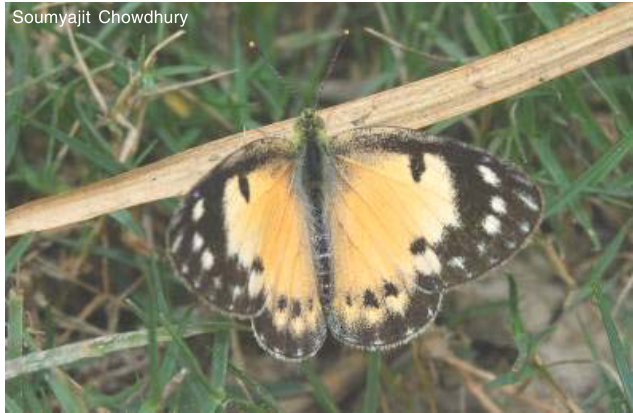
Image 1. Small Salmon Arab male showing upperside. photographed in Piyali, 7 December 2008.